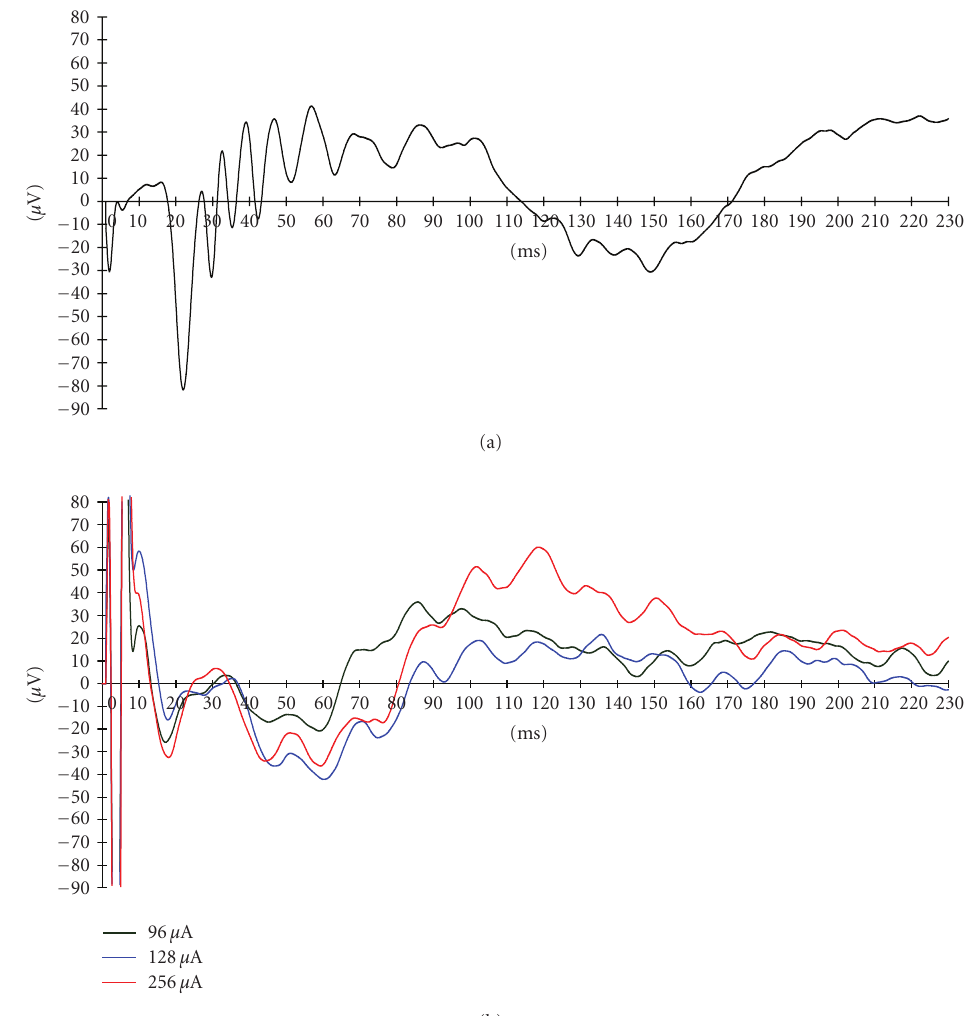
Figure 8: (a) Visual-evoked cortical potential (VECP) recorded before implantation of electrodes. (b) Electrically evoked cortical potentials (EECP) following retinal stimulation with a suprachoroidal